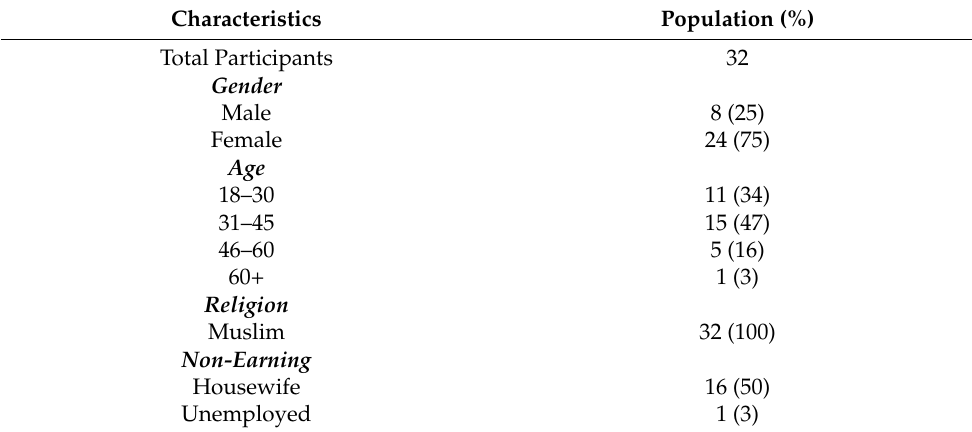
Table 1. The participant profiles of the low-income urban residents of Arichpur, Dhaka, from May 2015 to March